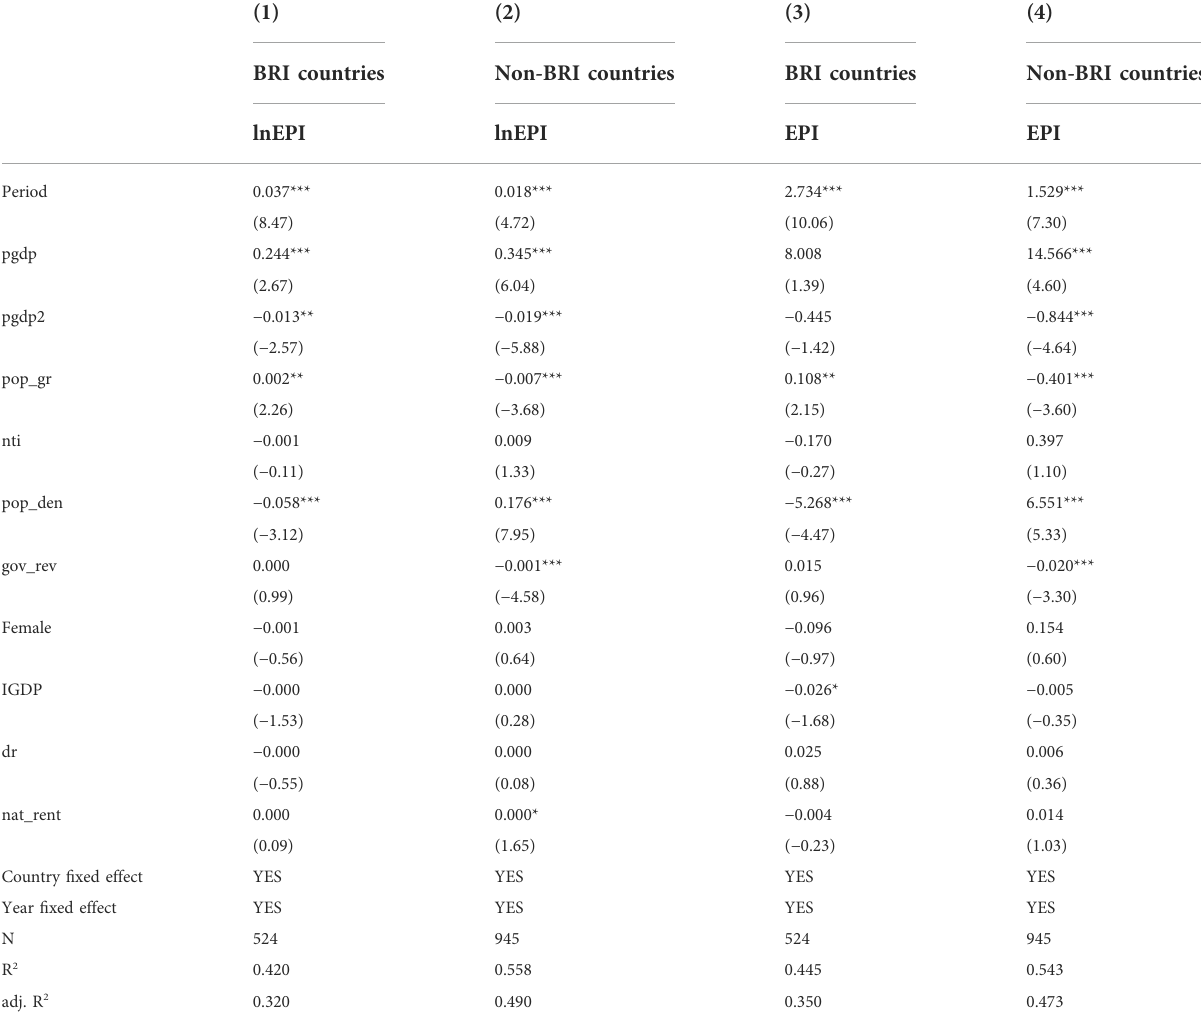
TABLE 14 Effects of the Belt and Road Initiative on environmental quality: The Belt and Road countries or